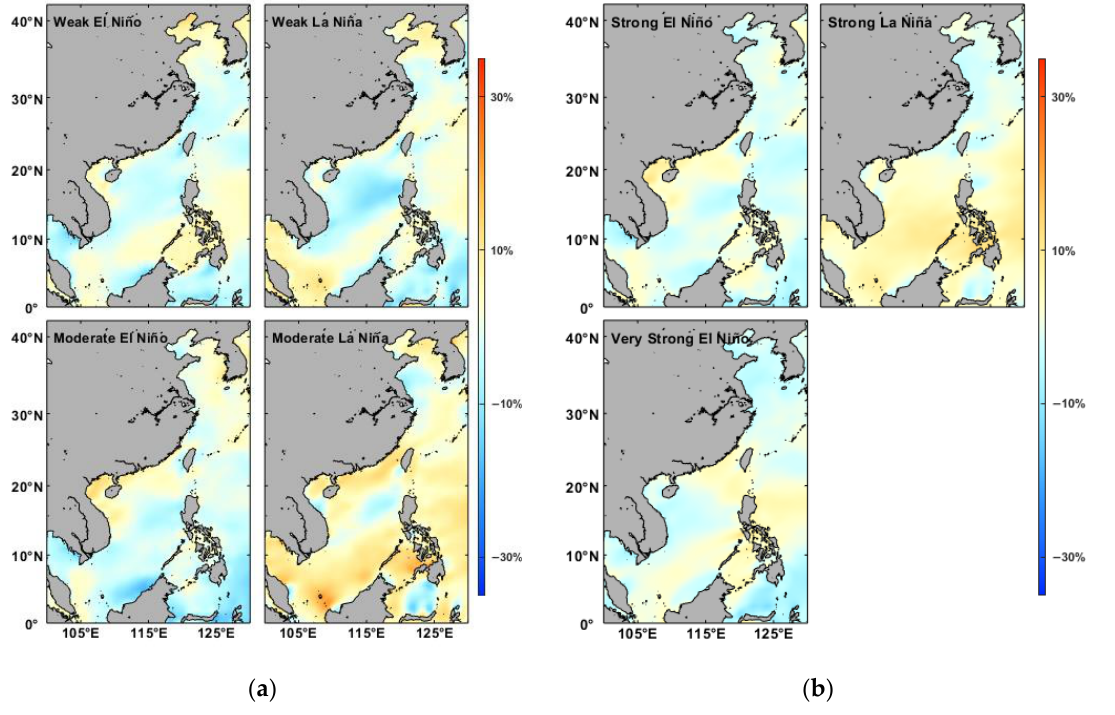
Figure 13. The percentage change in wind speed at different ENSO intensity levels: ( a ) Weak (upper panel) and moderate (lower panel) ENSO events; ( b ) Strong (upper panel) and very strong (lower panel) ENSO events.